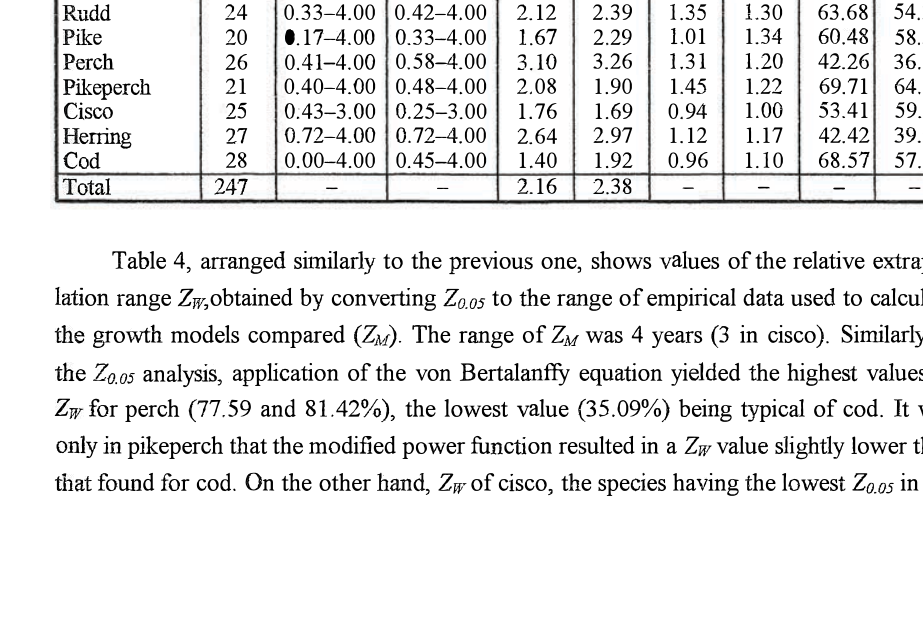
Extrapolation range (Zo os ) of von Bertalanffy equation (a) and modified power function (b) calculated for fish species